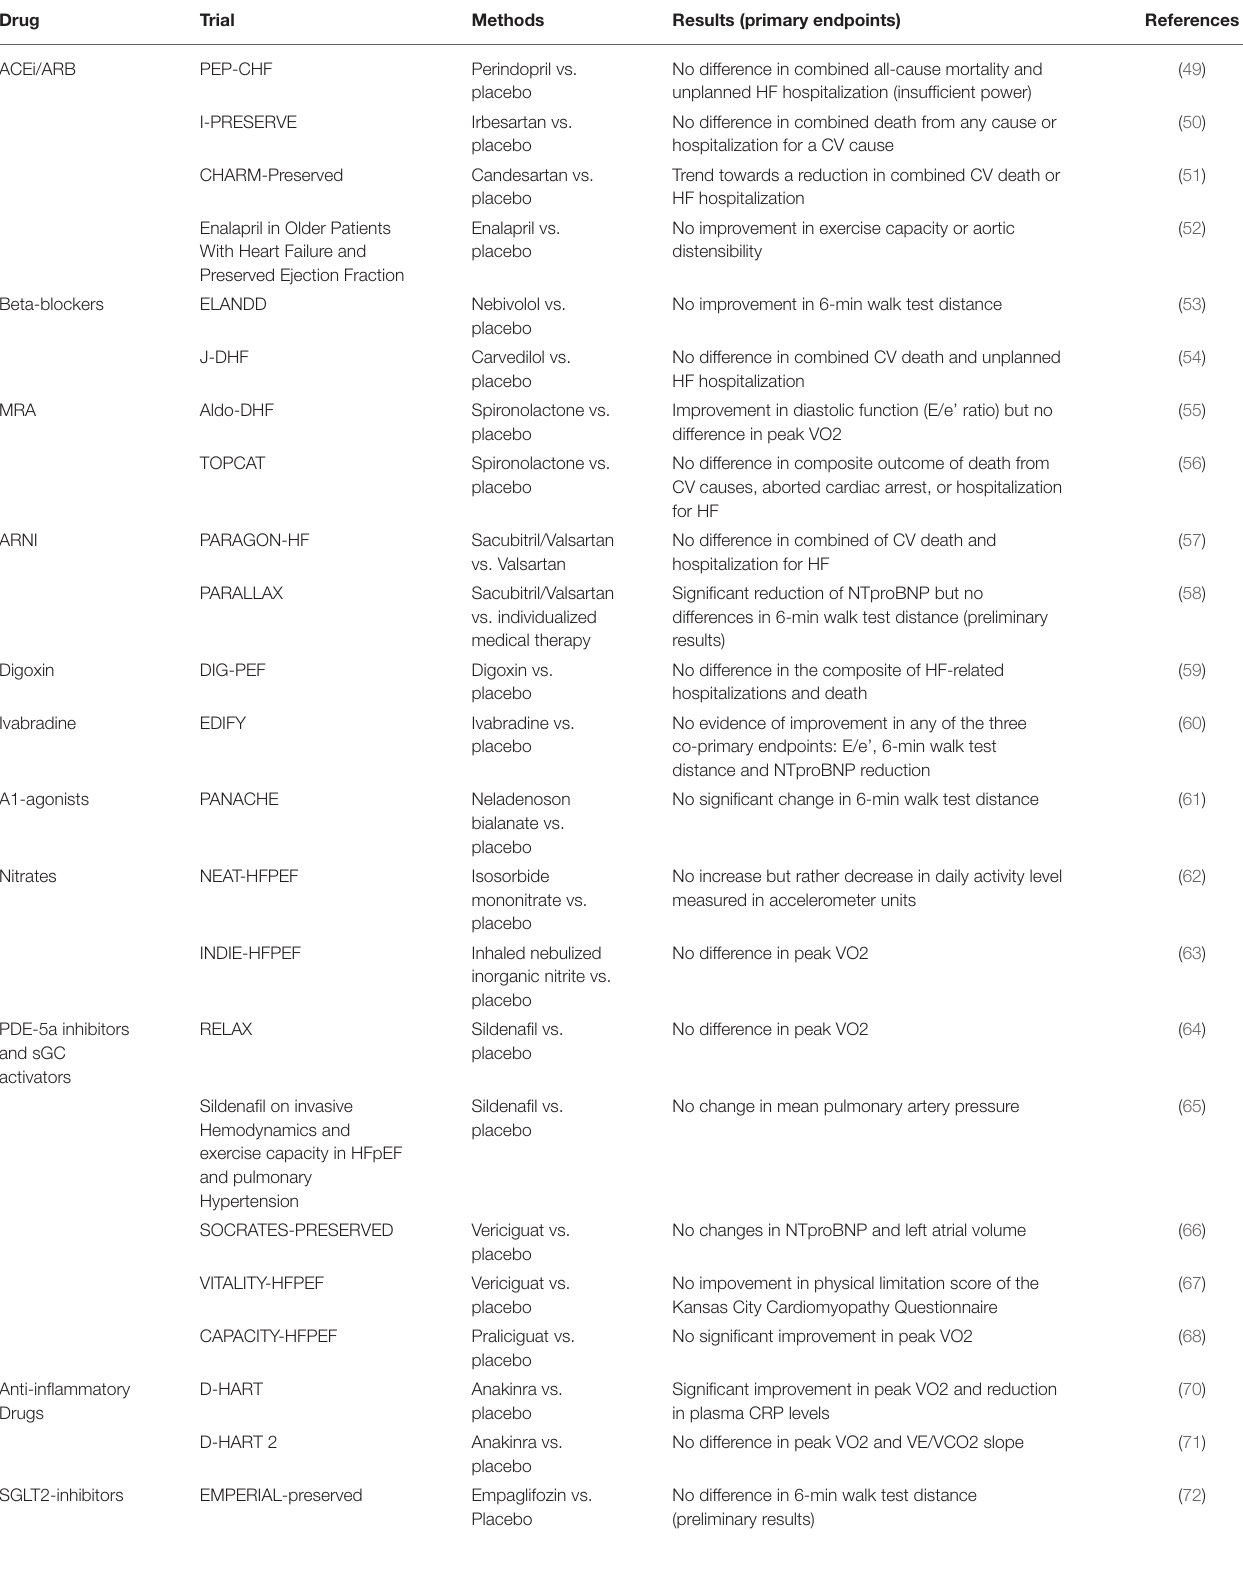
TABLE 1 | Clinical trials of pharmacological therapies for heart failure with preserved ejection fraction.